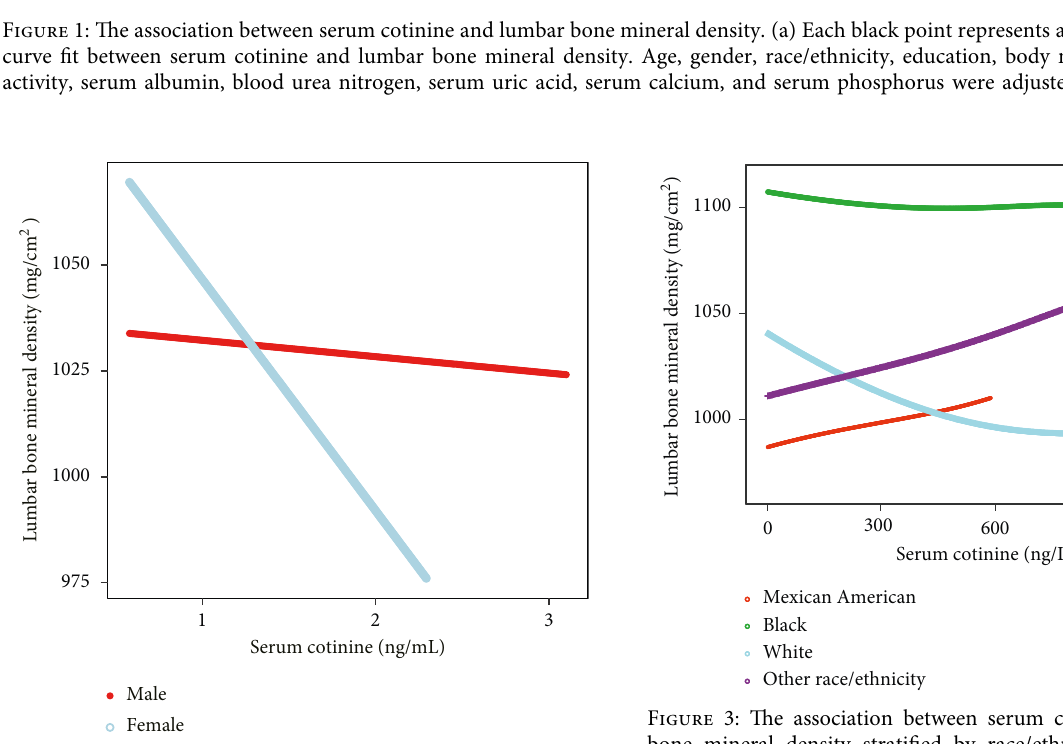
Figure 2: The association between serum cotinine and lumbar bone mineral density stratified by sex. Age, race/ethnicity, edu- cation, body mass index, physical activity, serum albumin, blood urea nitrogen, serum uric acid, serum calcium, and serum phos- phorus were adjusted.